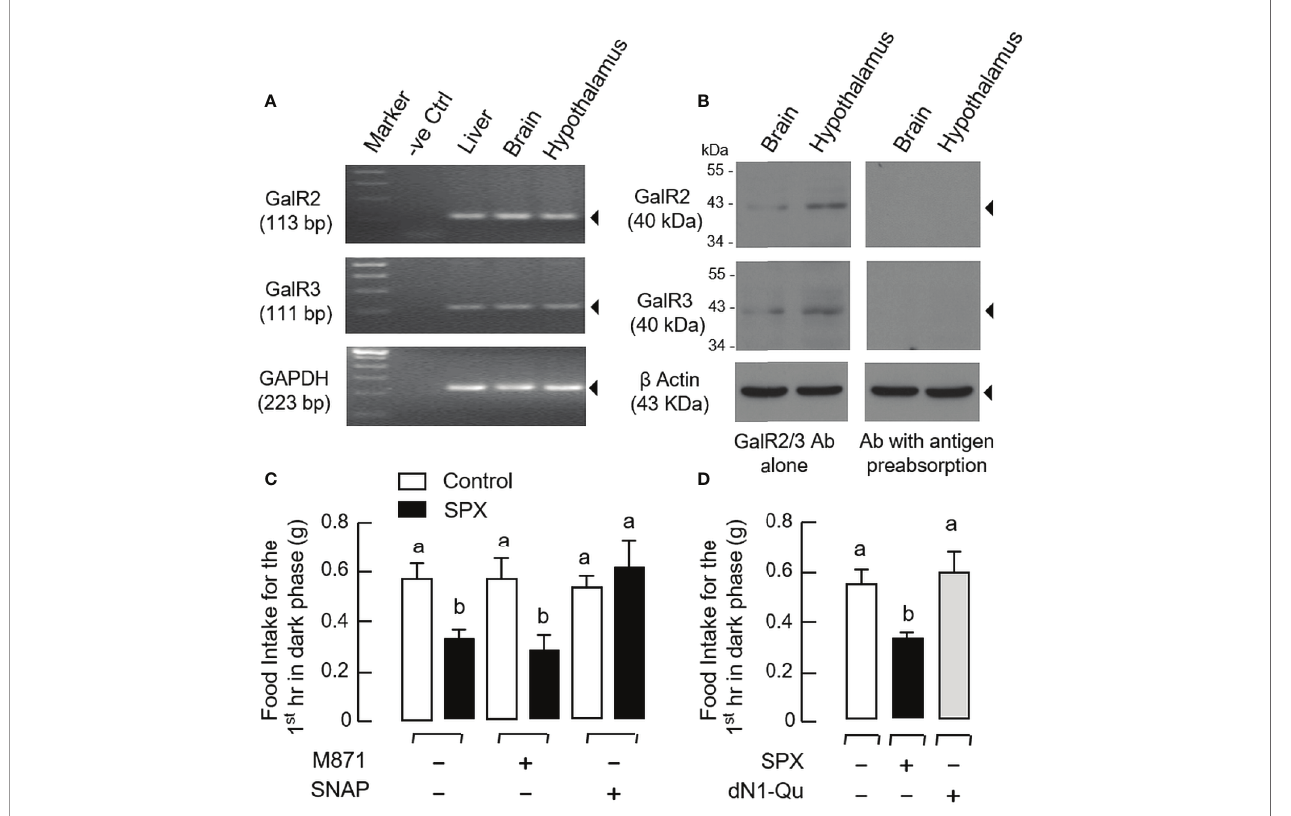
FIGURE 4 | Receptor speci fi city for SPX inhibition on food consumption in mice. (A) RT-PCR for GalR2 and GalR3 expression in the liver, brain and hypothalamus. Total RNA isolated from target tissues was used for RT-PCR with primers for GalR2 and GalR3, respectively, with GAPDH as internal control and PCR with no template as negative control ( “ -ve Ctrl ” ). (B) Western blot of GalR2 and GalR3 expression in the brain and hypothalamus. Tissue lysate was prepared from mouse brain and hypothalamus and subjected to SDS- PAGE and Western blot using the antibody (Ab) for GalR2 and GalR3, respectively, with b actin as loading control. To con fi rm the speci fi city of immunoblotting, Western blot was also conducted with antibodies pre-absorbed with the synthetic peptides for GalR2/3 used to raise the antibody provided by the company. (C) GalR2 and GalR3 blockade on the inhibitory effect of SPX on food intake in mice. IP injection of SPX (5 nmol/mouse) was performed at 10:00 AM with/without co-treatment of the GalR2 antagonist M871 (50 nmol/mouse) or GalR3 antagonist SNAP (50 nmol/mouse) to test the effect on food consumption occurred during the fi rst hour in dark phase. (D) Effect of GalR2 activation on food consumption in mice. In parallel experiment, IP injection of the GalR2 agonist dN1-Qu (10 nmol/mouse) was conducted with SPX treatment (10 nmol/mouse) as positive control. For the data presented, the groups denoted by different letters represent a signi fi cant difference at p <